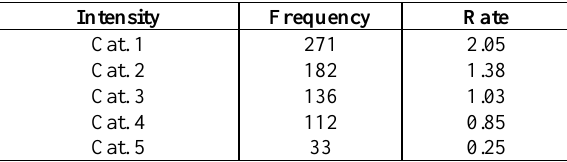
Table 4. The frequency and the rate of hurricanes for each SSHWS category in the ACR from 1886 to